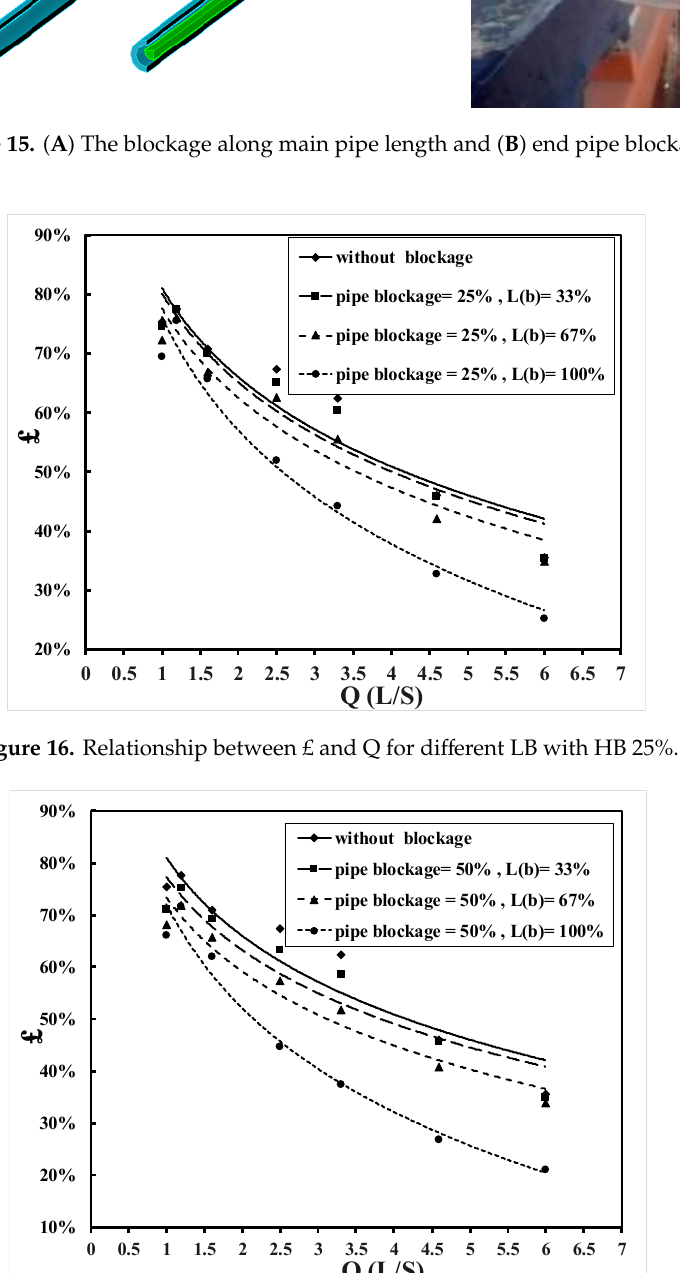
ff erent LB with HB Figure 17. Relationship between £ and Q for different LB with HB 50%. Figure 17. Relationship between £ and Q for di Figure 17. Relationship between £ and Q for different LB with HB 50%.